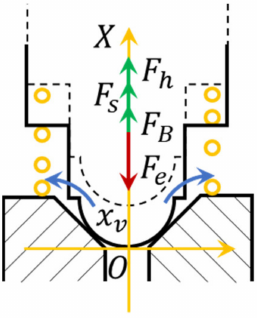
Figure 8. Coordinate system of solenoid valve.